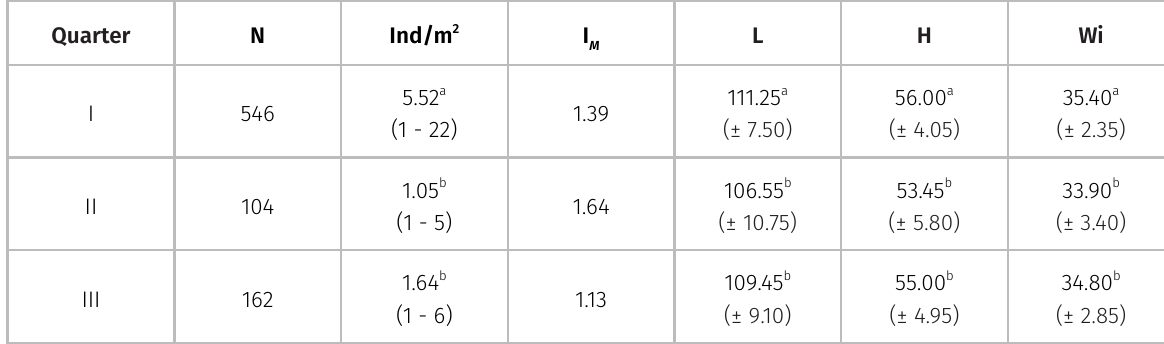
Different letters represent significantly different means. H, shell height. L, shell length. Wi, shell